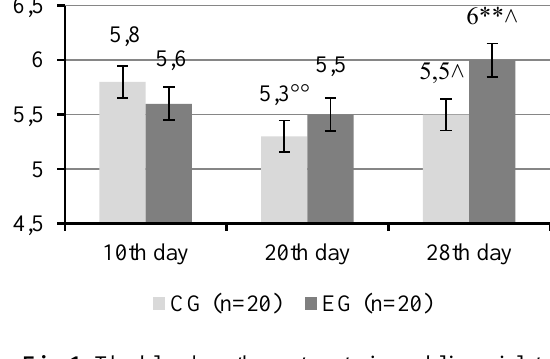
Fig. 1. The blood erythrocyte rate in suckling piglets